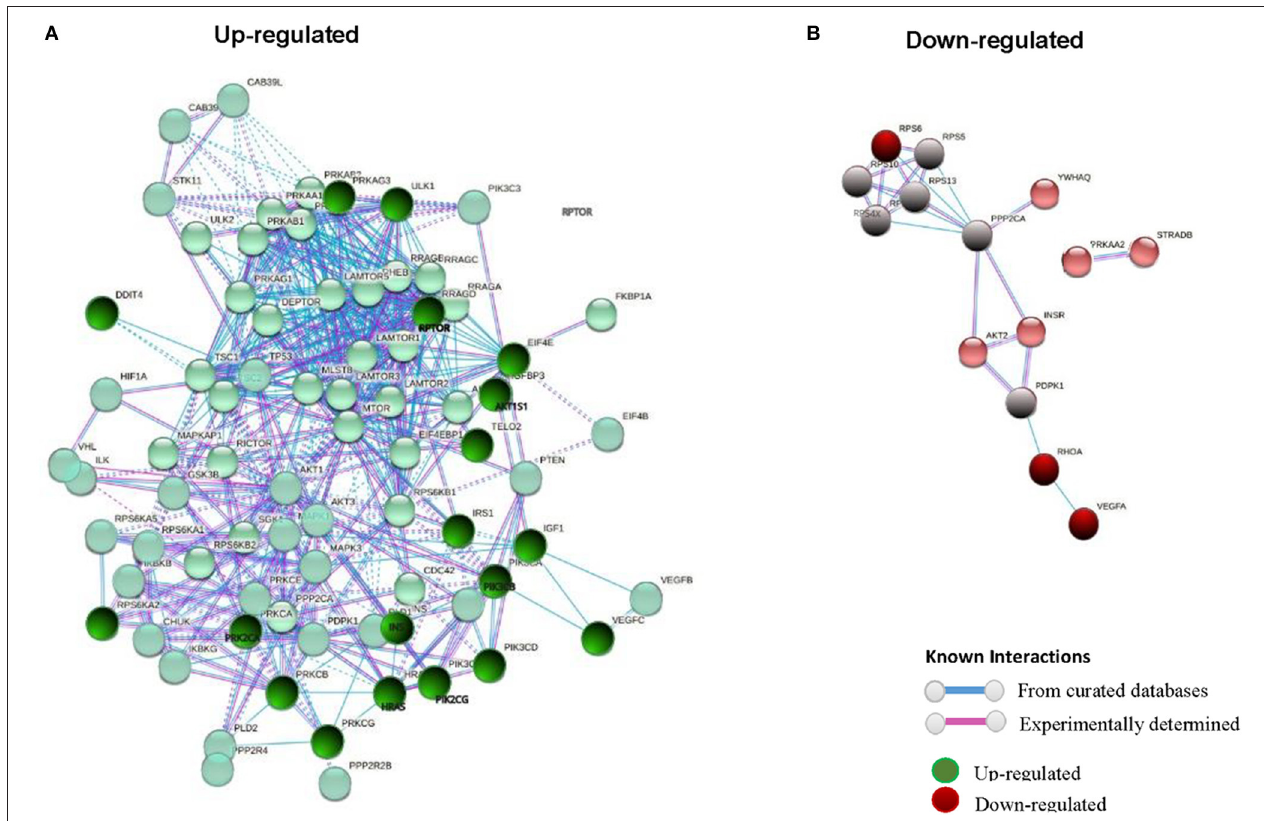
FIGURE 3 | STRING interaction pathway of differentially expressed mTOR pathway genes comparing + AMR/ + DSA and + DSA vs. –AMR/–DSA KT patients. (A) Green nodes indicate up-regulated genes. (B) Red nodes indicate down-regulated genes. The intensity of the color indicates the degree of regulation of the gene. The blue line shows that the interaction is checked against from curated databases and the purple line shows that the interaction is experimentally